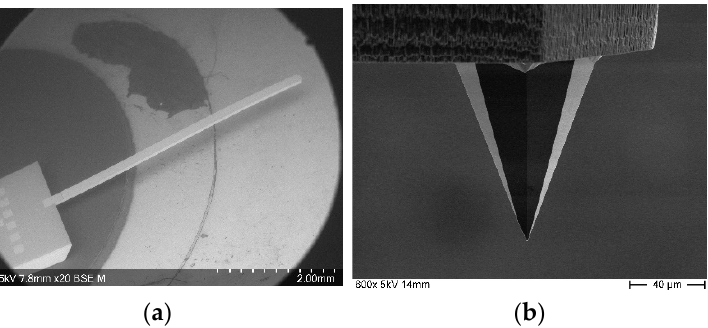
Figure 1. The scanning electron microscope images of the microprobe . ( a ) Sample of 5-mm long piezoresistive microprobe; ( b ) integrated silicon tip.